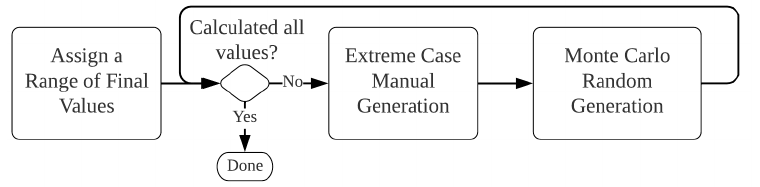
Figure 6. Overview of the growth trajectory